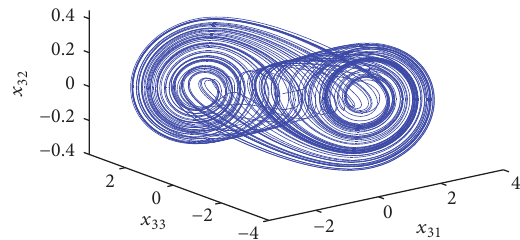
Figure 2: The chaotic behavior of time-delayed Chua oscillator.